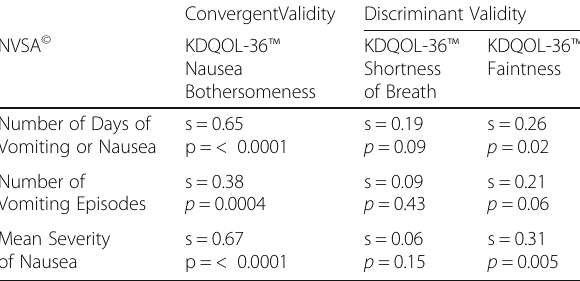
Table 4 Assessment of convergent and discriminant validity of NVSA © Scores with the KDQOL-36: ™ Week